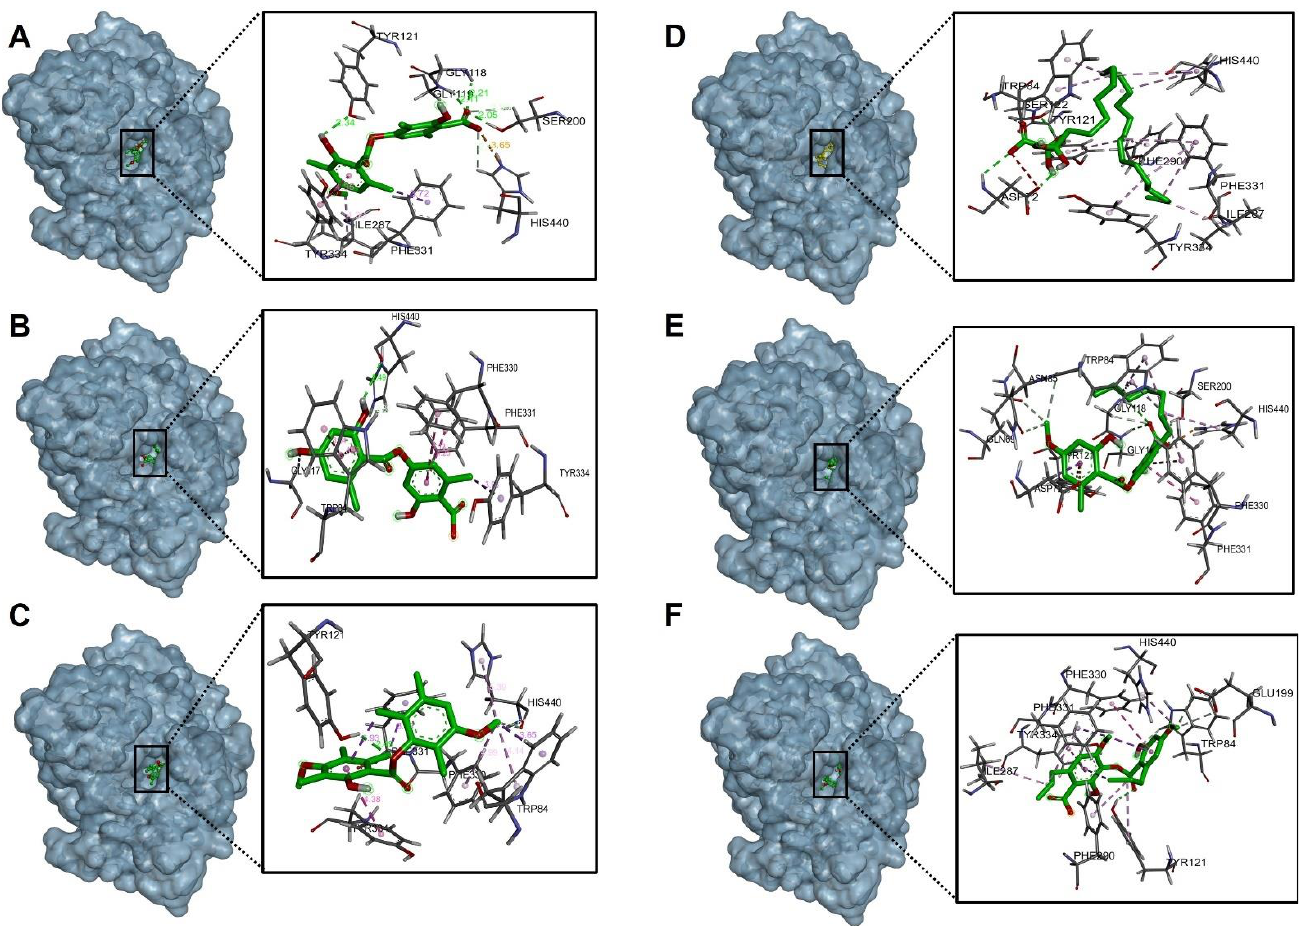
Figure 3. Binding mode and predicted intermolecular interactions of selected compounds from Lecania brialmontii , Pseudephebe pubescens and Sphaerophorus globosus extracts and residues of the Torpedo californica acetylcholinesterase (TcAChE) catalytic site; ( A ) Barbatic acid at the catalytic site; ( B ) Lecanoric acid at the catalytic site; ( C ) Brialmontin 2 at the catalytic site; ( D ) Tetra- hydroxytricosanoic acid at the catalytic site; ( E ) Sphaerophorin at the catalytic site; ( F ) Sekikaic acid at the catalytic site.